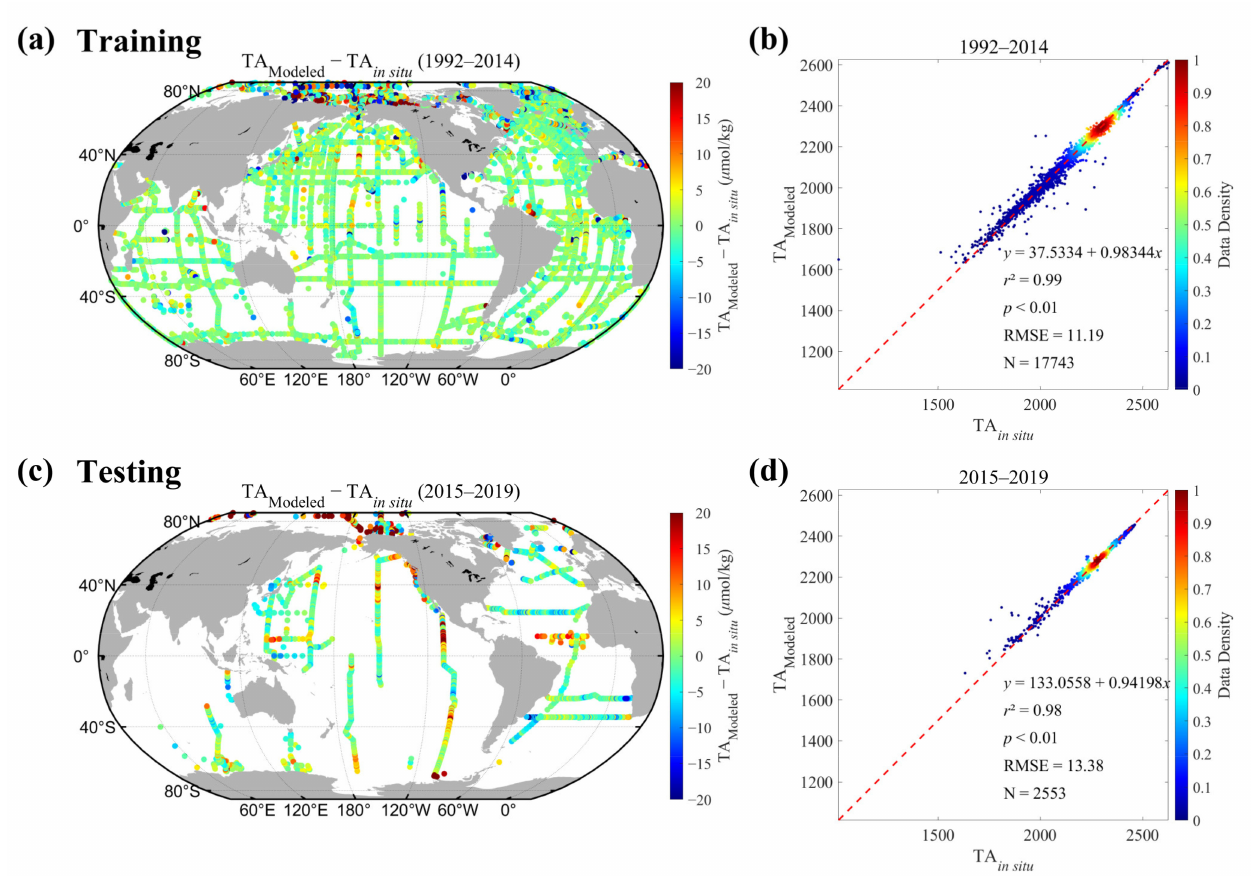
Figure 4. Training and testing of the TA inversion model based on the RF algorithm with inputs of LON, LAT, SST, and SSS. Spatial distributions of relative errors (the difference between the modeled value and TA ( in situ *)) in ( a ) the training set (1992–2014) and ( c ) the testing dataset (2015–2019). Scatter plots of the comparison between the modeled value and TA ( in situ *) for ( b ) the training set and ( d ) the testing dataset. The red dotted line is 1:1 line.